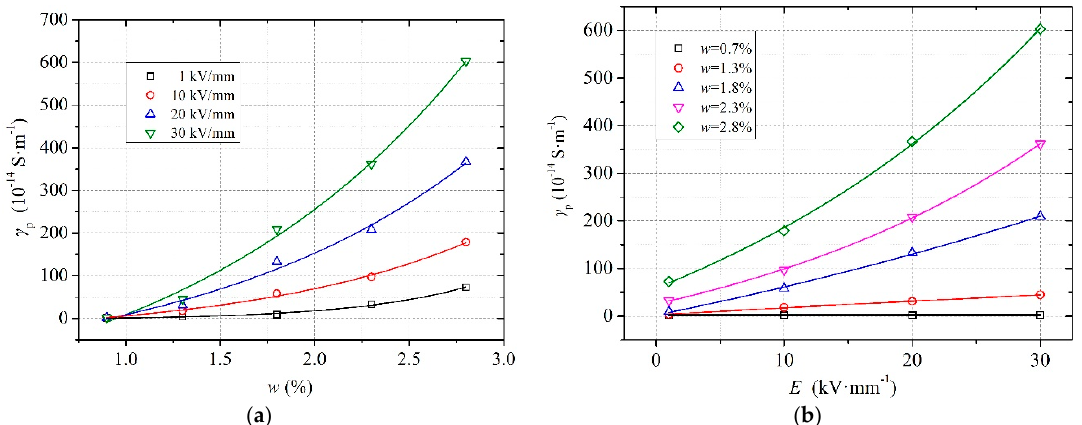
Figure 6. Relationship between pressboard conductivity and moisture/electric field strength (25 °C): ( a ) Moisture as the x coordinate; ( b ) Electric field strength as the x coordinate.